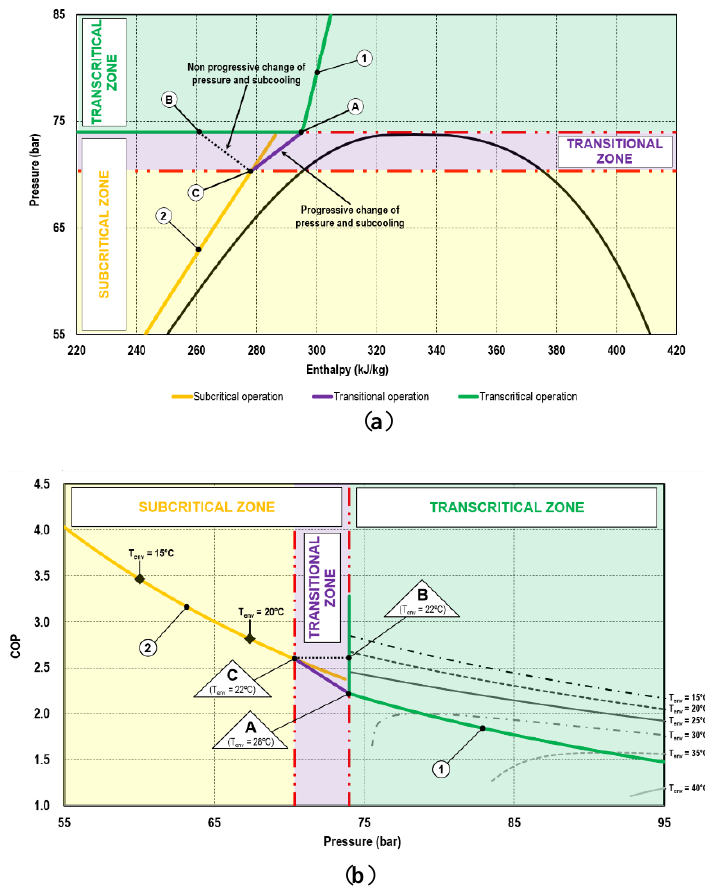
Figure 7. HPCV operation for booster (( a ) (P vs. h), ( b ) (COP vs. P)) in subcritical, transitional, and transcritical zones.